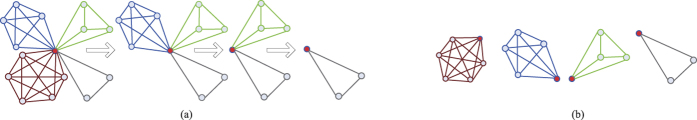
An illustration of our main idea.(a) Network decomposition procedure of our method, (b) Result of our method.